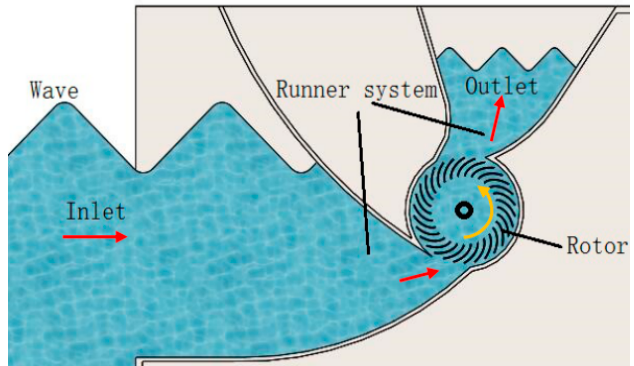
Figure 1. Cutaway view of the device.